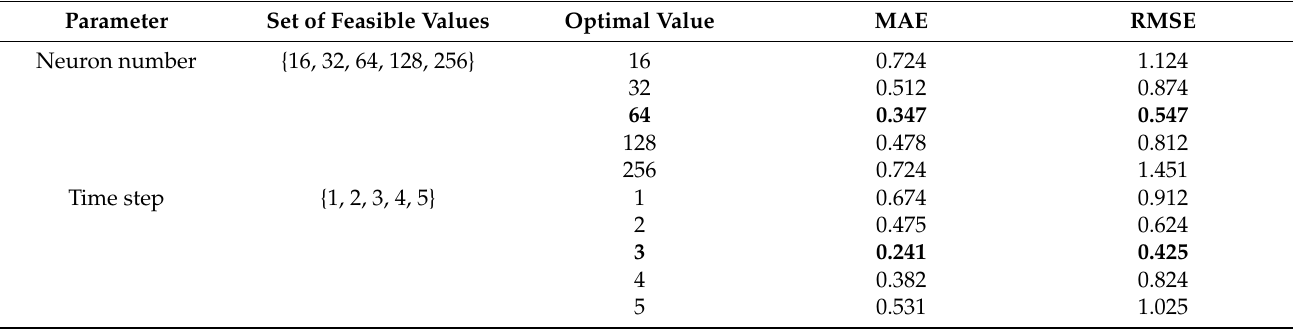
Table 4. Optimal parameters of the CT-VGG-GRU model. The best hyperparameters and experimen- tal results are highlighted in